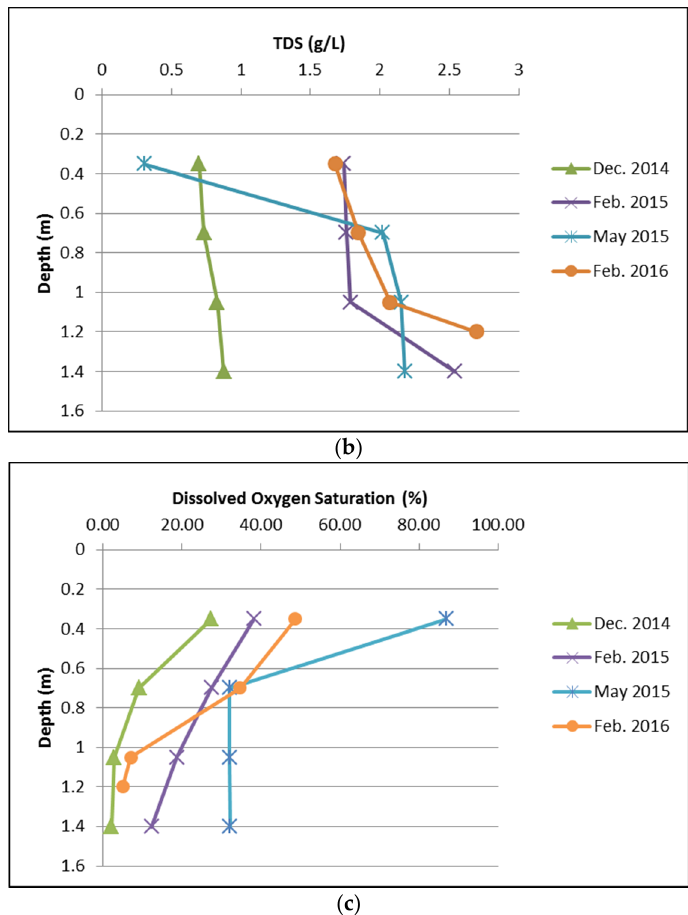
Figure 11. Vertical profile results: Temperature ( a ); TDS ( b ); dissolved oxygen (DO) ( c ).